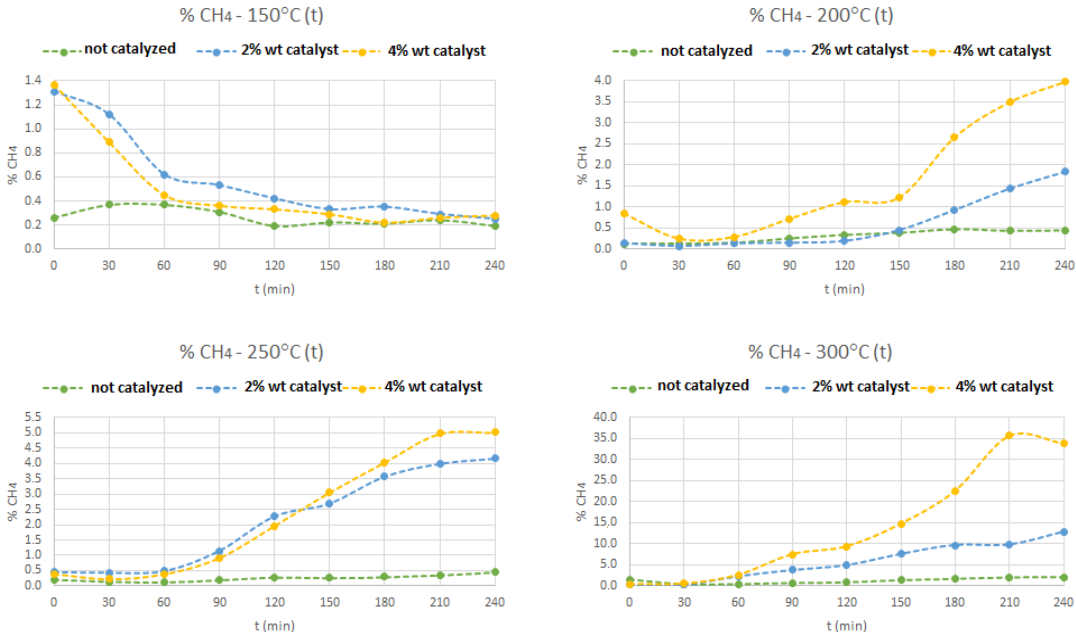
Figure 8. Comparison of the behavior of the percentage of methane in the gas produced over the test time for the synthesis gas production tests for different amounts of catalyst and temperature (average values).